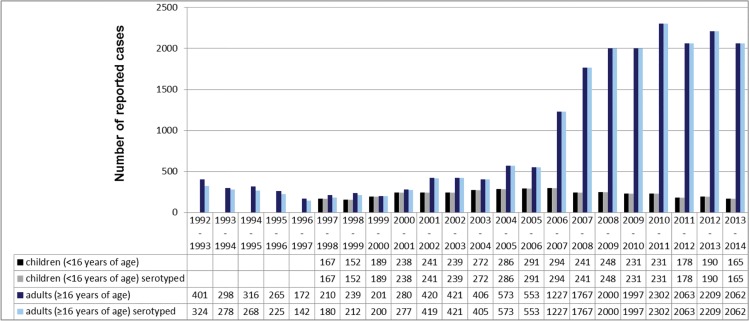
Numbers of reported IPD isolates among children (n = 3,853, all serotyped) and adults (n = 20,382, serotyped: n = 20,104) in Germany.